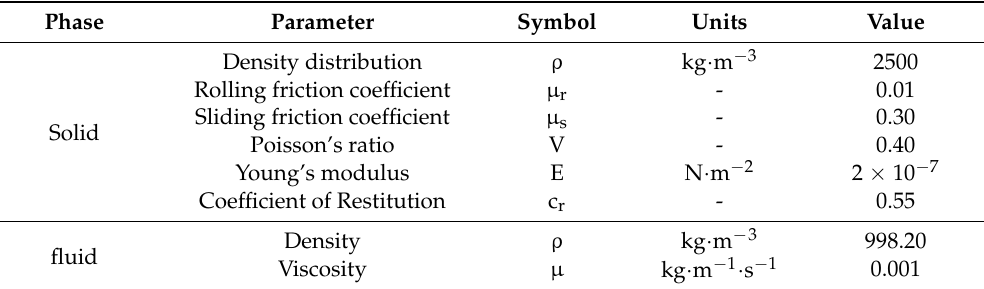
Table 2. Parameters used in the model.